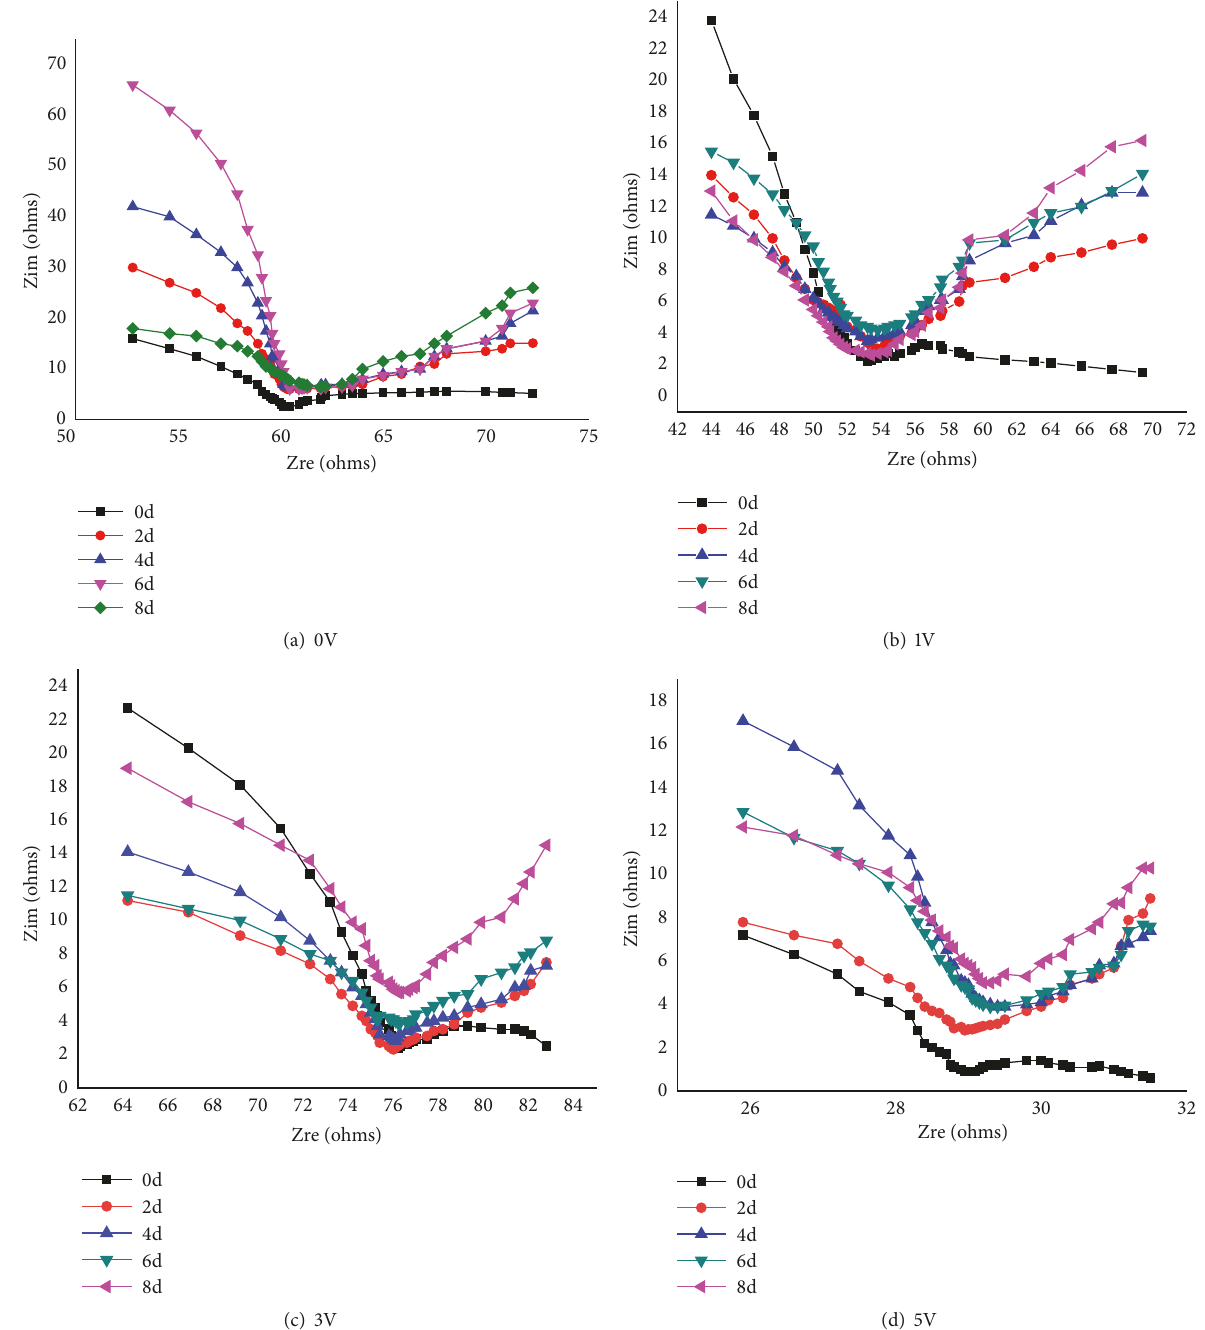
Figure 3: The EIS of magnesium sacrificial anode under different AC interference voltages at an ambient temperature of 20 ∘ C in the test